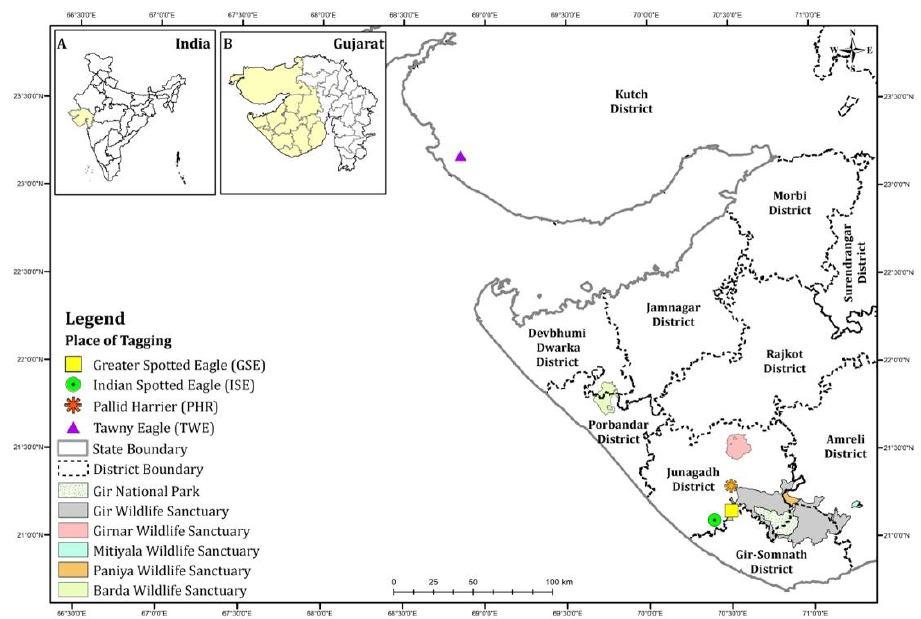
Figure 1. Location of Saurashtra and Kutch District. Greater Spotted Eagle (GSE), Indian Spotted Eagle (ISE), and Pallid Harrier (PHR) were tagged in Saurashtra Landscape (bottom-right corner), and Tawny Eagle (TWE) was tagged in Kutch District (upper-left corner). Map insets indicate the location of Gujarat in India ( A ) and the study area in Gujarat state ( B ).